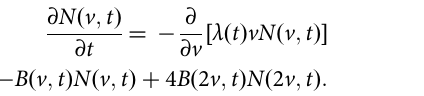
Table 1 Parameters used for the simulations. Parameters on the exponential